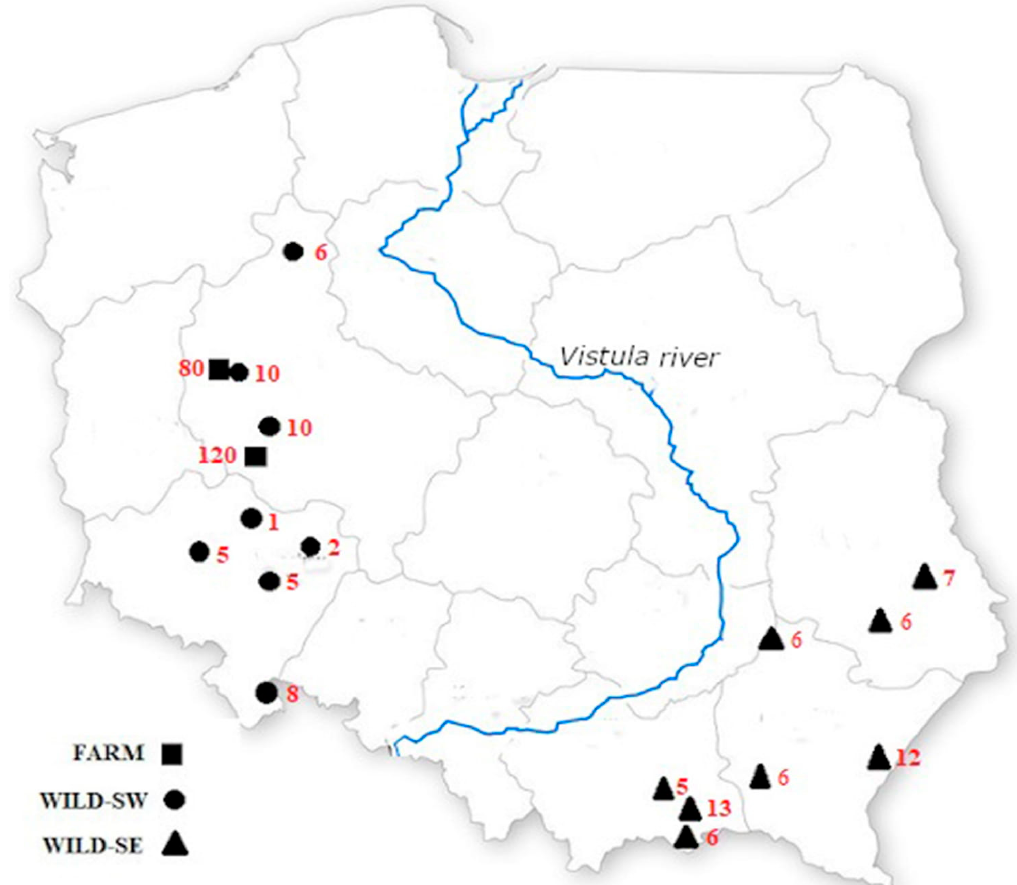
Figure 1. Map of the study area, sampling sites and their location.